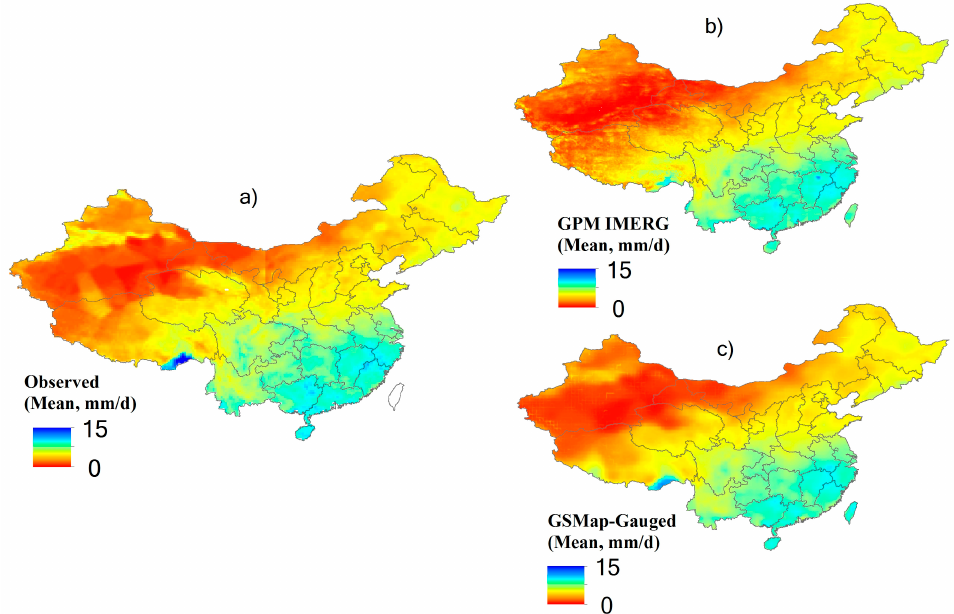
Figure 4. Distribution of daily mean precipitation over the Chinese mainland from April 2014 to November 2015. Units are mm/day. ( a ) CGDPA; ( b ) GPM IMERG; and ( c ) GSMap ‐ Gauge.